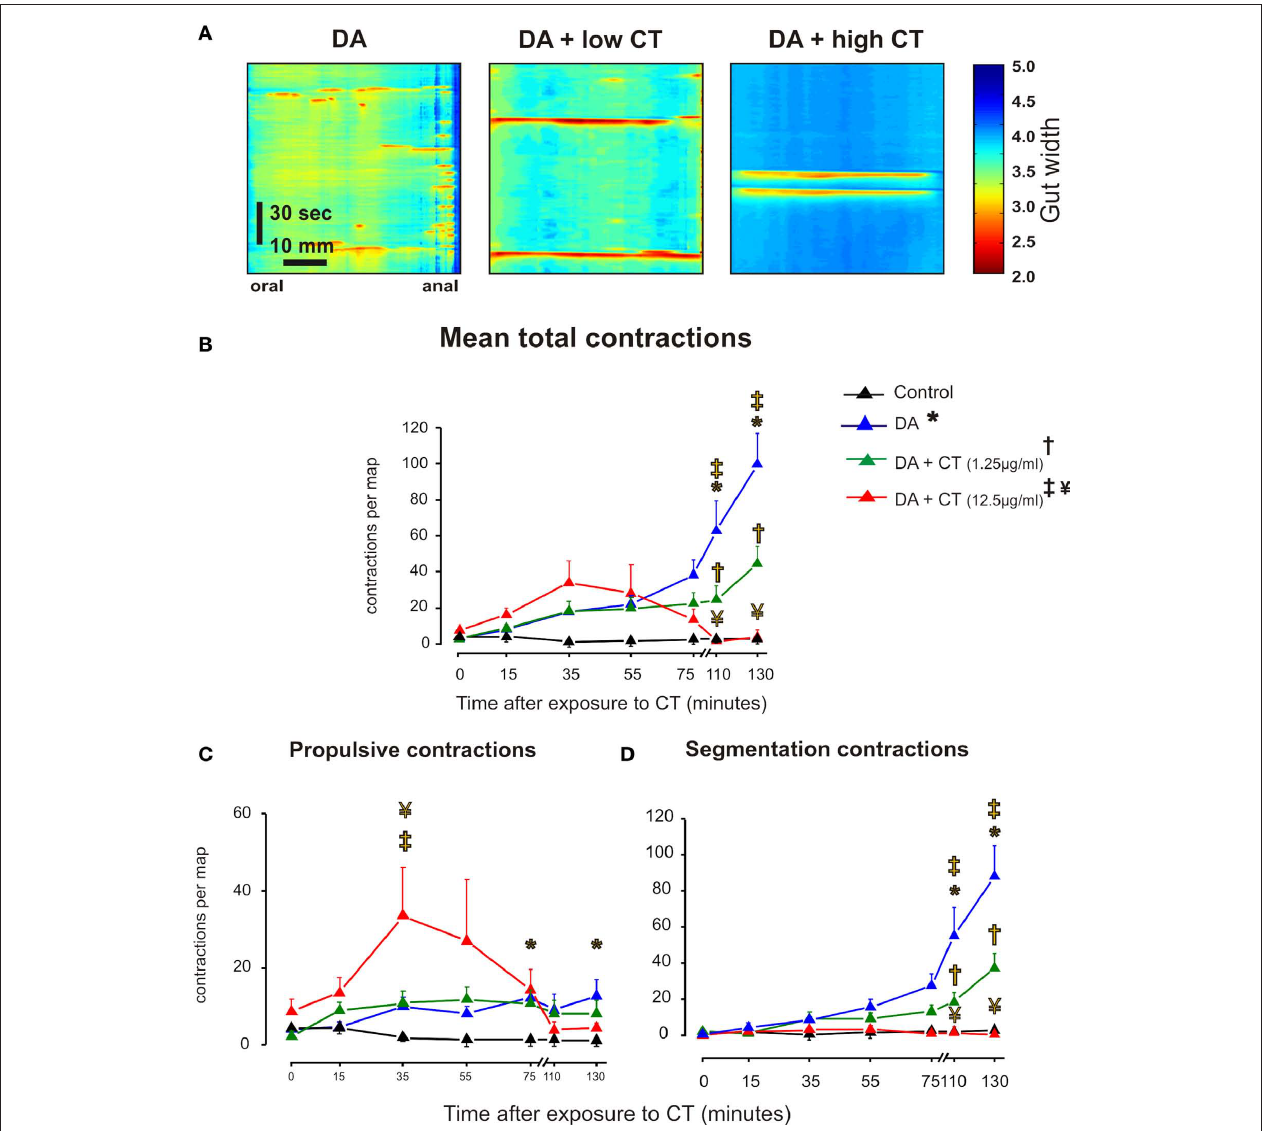
Figure 4 | Luminal CT depresses segmentation induced by decanoic acid (1 mM, DA). (A) Three minute maps of contractile activity taken after 120–140 min of luminal DA alone, DA plus low CT (1.25 μg/ml) and DA plus CT (12.5 μg/ml). (B) Overall contractile activity against time (black – time control, blue – DA alone, green – DA + low CT, red – DA + high CT. (C) Propulsive contractions; (D) . Segmentation. Curves: DA vs control